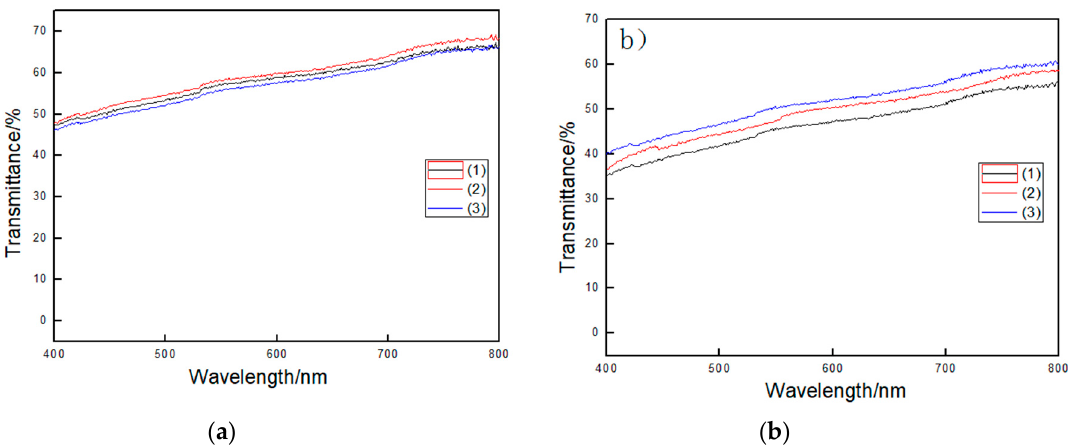
Figure 4. Transmittance at three different positions on the same sample: ( a ) 10 wt% STMFC/LLDPE and ( b ) 14 wt% STMFC/LLDPE. and ( b ) 14 wt%